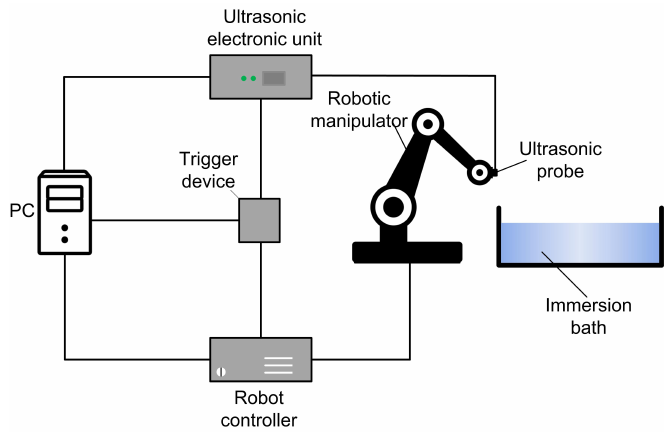
Figure 4. The scheme of experimental